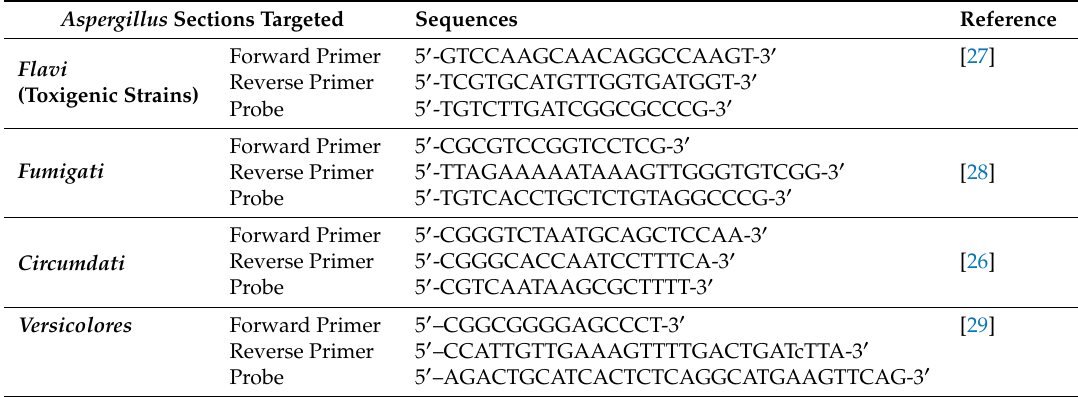
Table 2. Sequence of primers and TaqMan probes used for Real Time